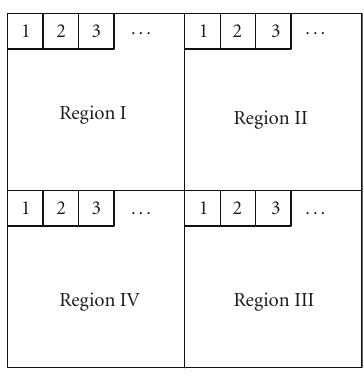
Figure 2: An example of region division and number